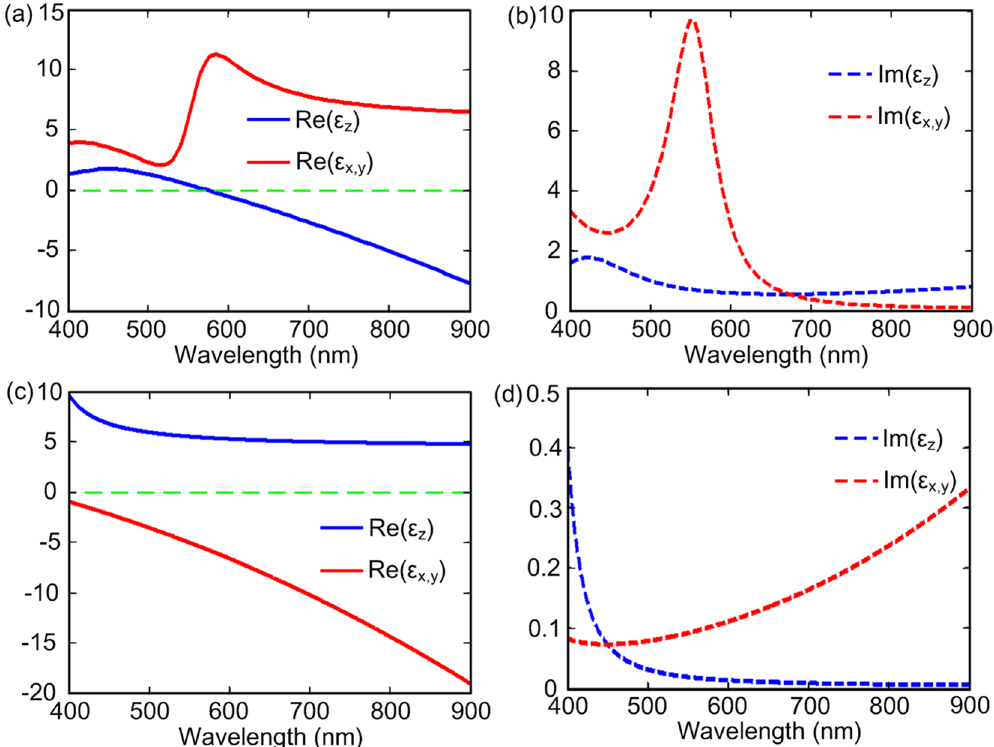
Figure 3. Dielectric functions of type I and type II hyperbolic metamaterials. ( a ) Real and ( b ) imaginary parts of the dielectric functions of gold nanorod arrays embedded into the Al 2 O 3 host ( p = 0.3). ( c ) Real and ( d ) imaginary parts of the dielectric functions of a silver-silica lamellar structure ( f m = 0.5). In the overlapping spectral range 575–900 nm, both type I and type II HMMs are realizable. Green dashed lines separate the positive and negative values of the real parts of the dielectric